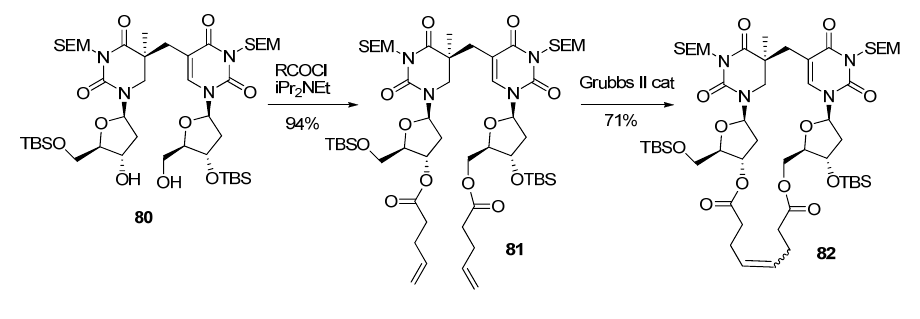
Scheme 19. Synthesis of the cyclic SP nucleoside